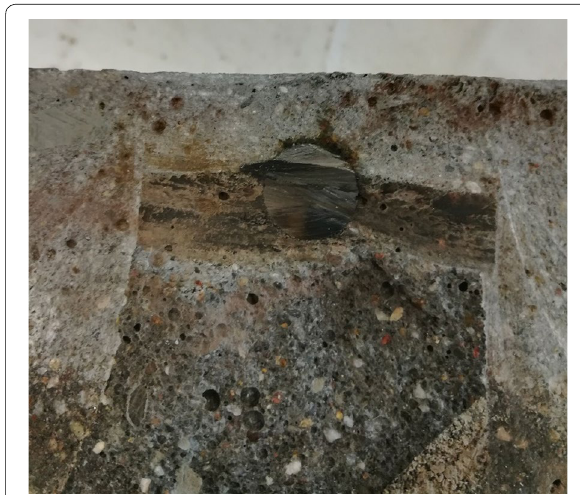
Fig. 7 Photo taken after cutting specimen number 10, at the end of its corrosion test. Steel corrosion products have concentrated on top of the steel rebar and are filling the open crack produced by